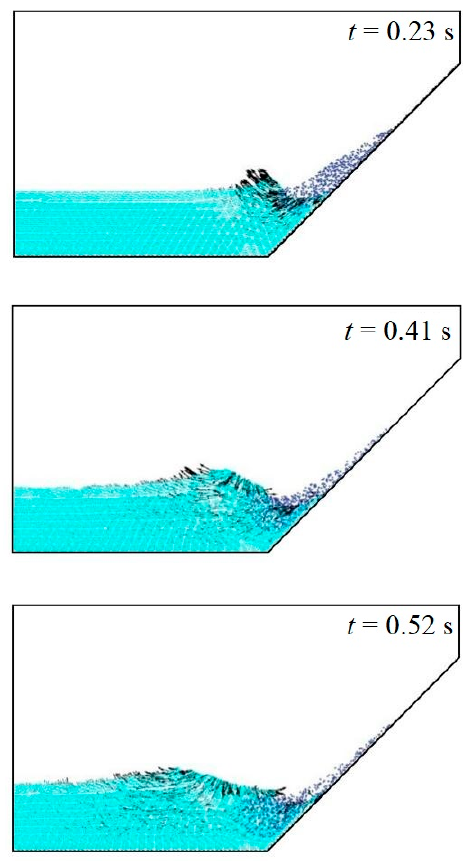
Figure 8. Simulation results of waves generated when particles enter water along a slope.